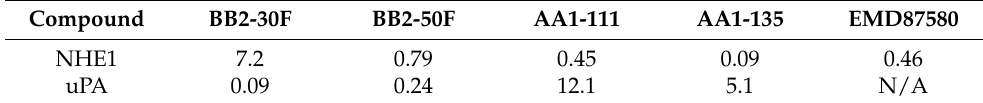
Table 1. Potency (IC 50 in µ M) of various compounds towards NHE1 and uPA.